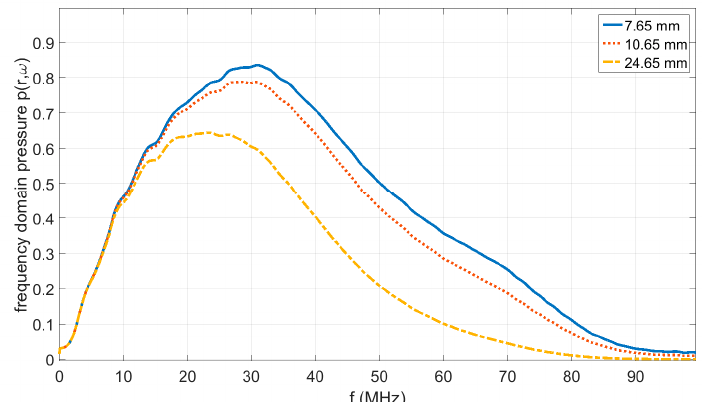
Figure 3. Amplitude of the Fourier transformation in time to get the frequency domain pressure amplitude from the measured signals shown in Figure 2 at a distance r of 7.65 mm, 10.65 mm, and 24.65 mm. The frequency response of the transducer is taken into account in the frequency domain by an additional factor (cid:101) T ( ω ) in Equation (4). The transducer limits the frequency bandwidth, and therefore, a significant influence according to Equation (4) on the bandwidth of the signals can be seen only for larger distances, such as that at 24.65 mm.